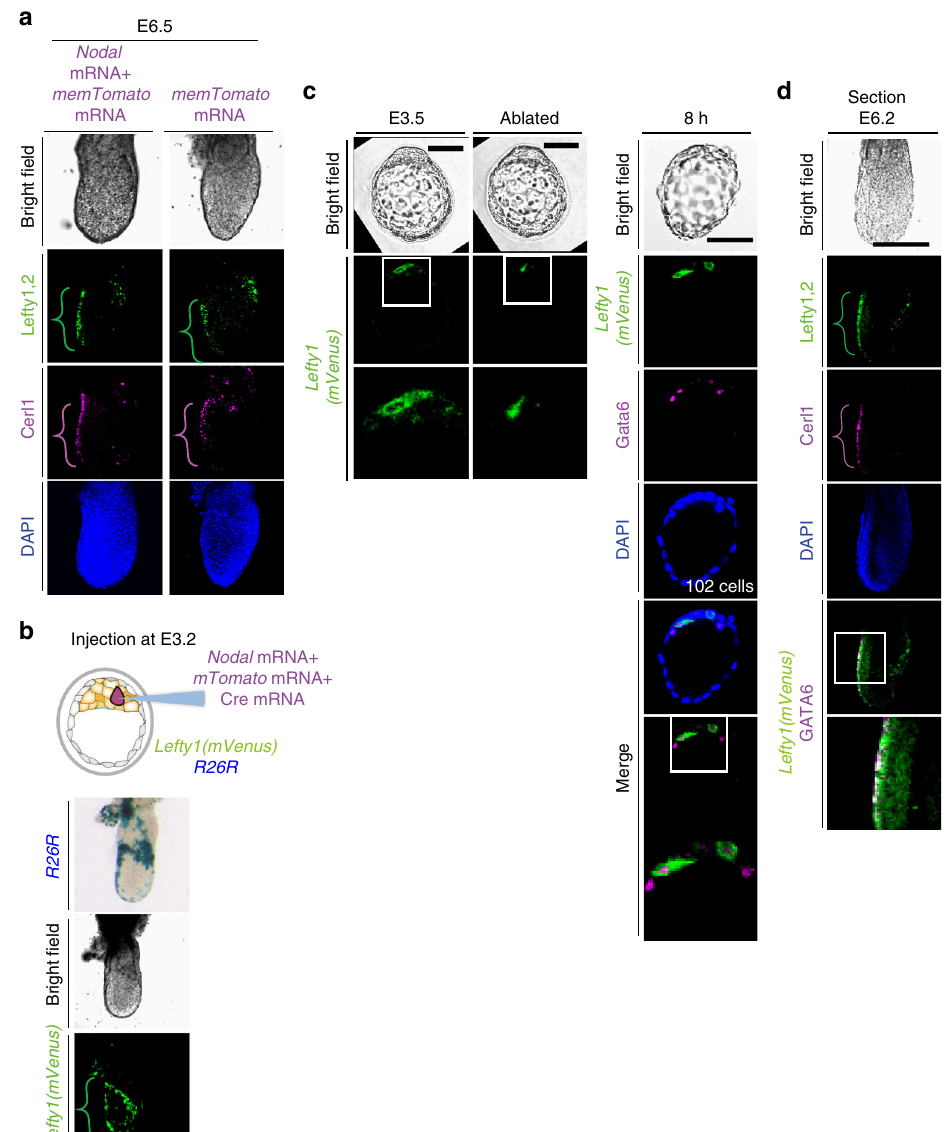
Fig. 6 Ablation of L1 epi cells at E3.5 results in the appearance of new L1 epi cells and does not impair A – P patterning. a E3.2 embryos in which a single cell had been injected with mTomato mRNA alone or together with Nodal mRNA were transferred to a pseudopregnant mouse, allowed to develop until E6.5, and then recovered for immuno fl uorescence staining of A – P markers. The brackets denote AVE located on the anterior side of the embryos. Lefty1, Lefty2, and Cerl1 were detected in AVE, the primitive streak, and AVE, respectively, suggesting that a normal A – P axis was established. b An E3.2 Rosa26R ( R26R ) embryo harboring a Lefty1(mVenus) BAC transgene was injected with Nodal mRNA, mTomato mRNA, and Cre mRNA, transferred to a pseudopregnant mouse, allowed to develop until E6.5, and then recovered for X-gal staining and immuno fl uorescence staining for mVenus. Note that the injected cell survived and contributed to DVE and DVE-derived cells. c All mVenus + cells (L1 epi cells) were removed by laser ablation from an E3.5 embryo harboring a Lefty1(mVenus) BAC transgene, after which the embryo was cultured for 8 h and then subjected to immuno fl uorescence staining for mVenus and GATA6. Note that fl uorescent membrane debris was detected immediately after ablation and that new mVenus + cells had appeared by 8 h after the ablation. Boxed areas are shown at higher magni fi cation in the images immediately below. Scale bar, 50 µ m. d After culture, an embryo such as that in ( c ) was transferred to a pseudopregnant mouse, allowed to develop until E6.5, and then recovered for immuno fl uorescence staining of A – P markers. Lefty1, Lefty2, and Cerl1 were detected in AVE, the primitive streak, and AVE, respectively. Scale bar, 100 µ